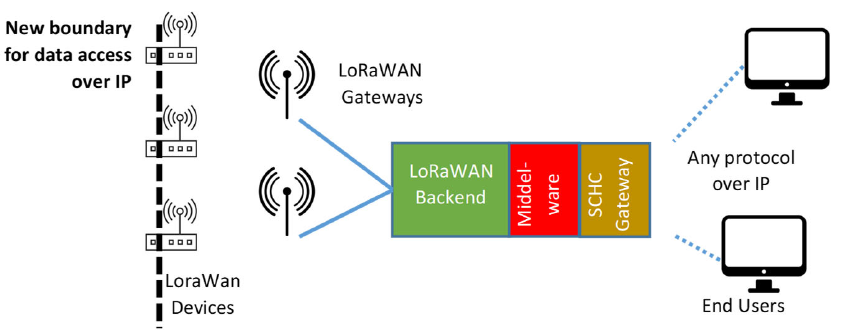
Figure 2. Block diagram of a SCHC ‐ based LoRaWAN solution, where data are accessible over the IP protocol at the end ‐ device level.